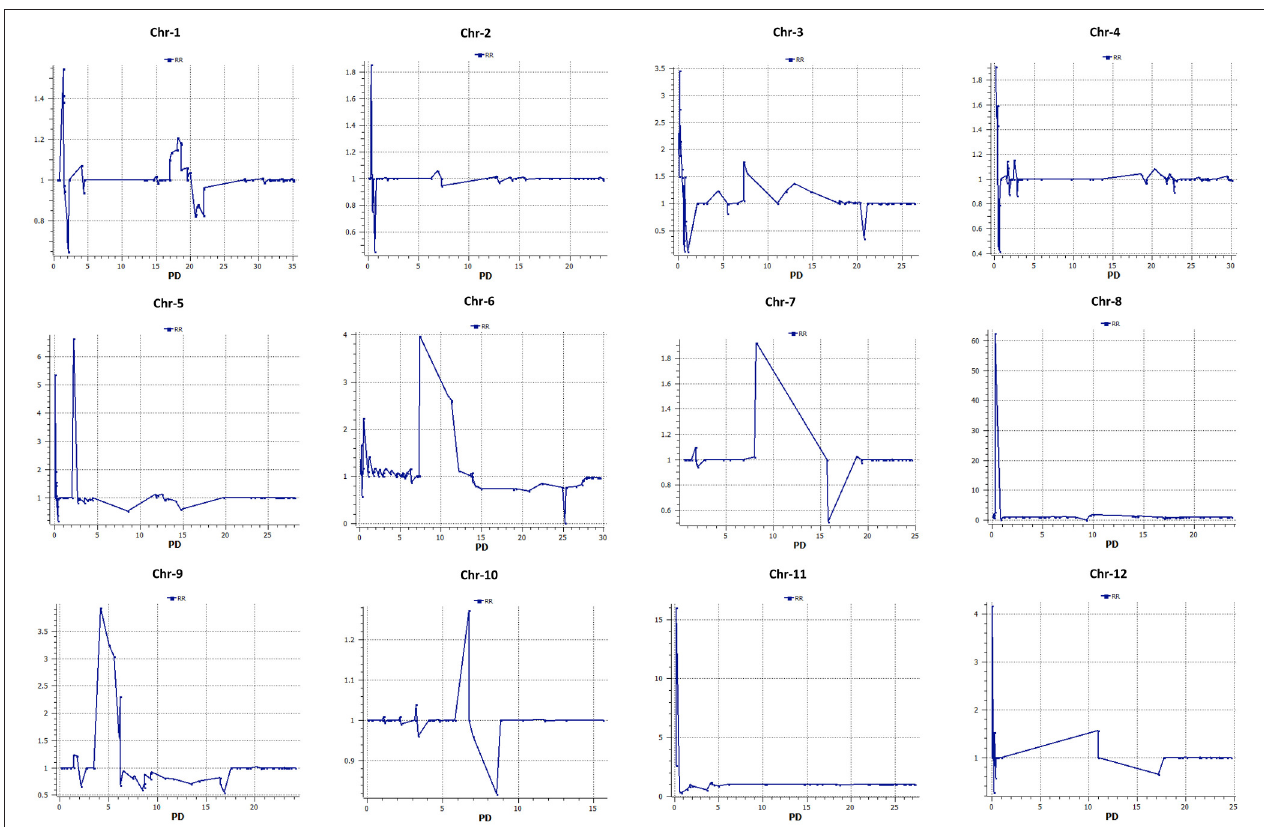
FIGURE 7 | Distribution of genome-wide recombination rate (GWRR) along chromosomes in the melon genome. In each plot, the horizontal axis (in Mb) represents the physical distance (PD) along the reference chromosomes and the vertical axis (cM/Mb) the genetic-to-physical distance ratio (green).